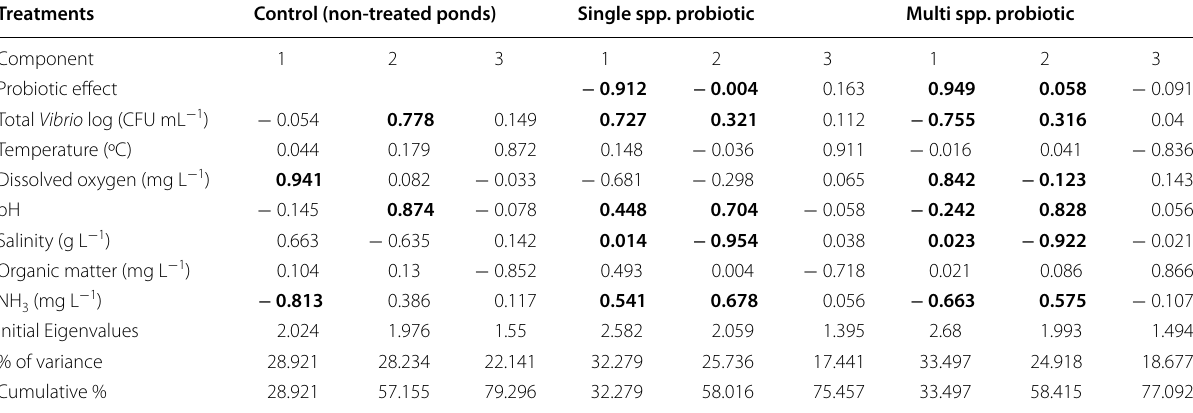
Table 4 Principal component analysis of the treatments with water quality parameters Treatments Control (non-treated